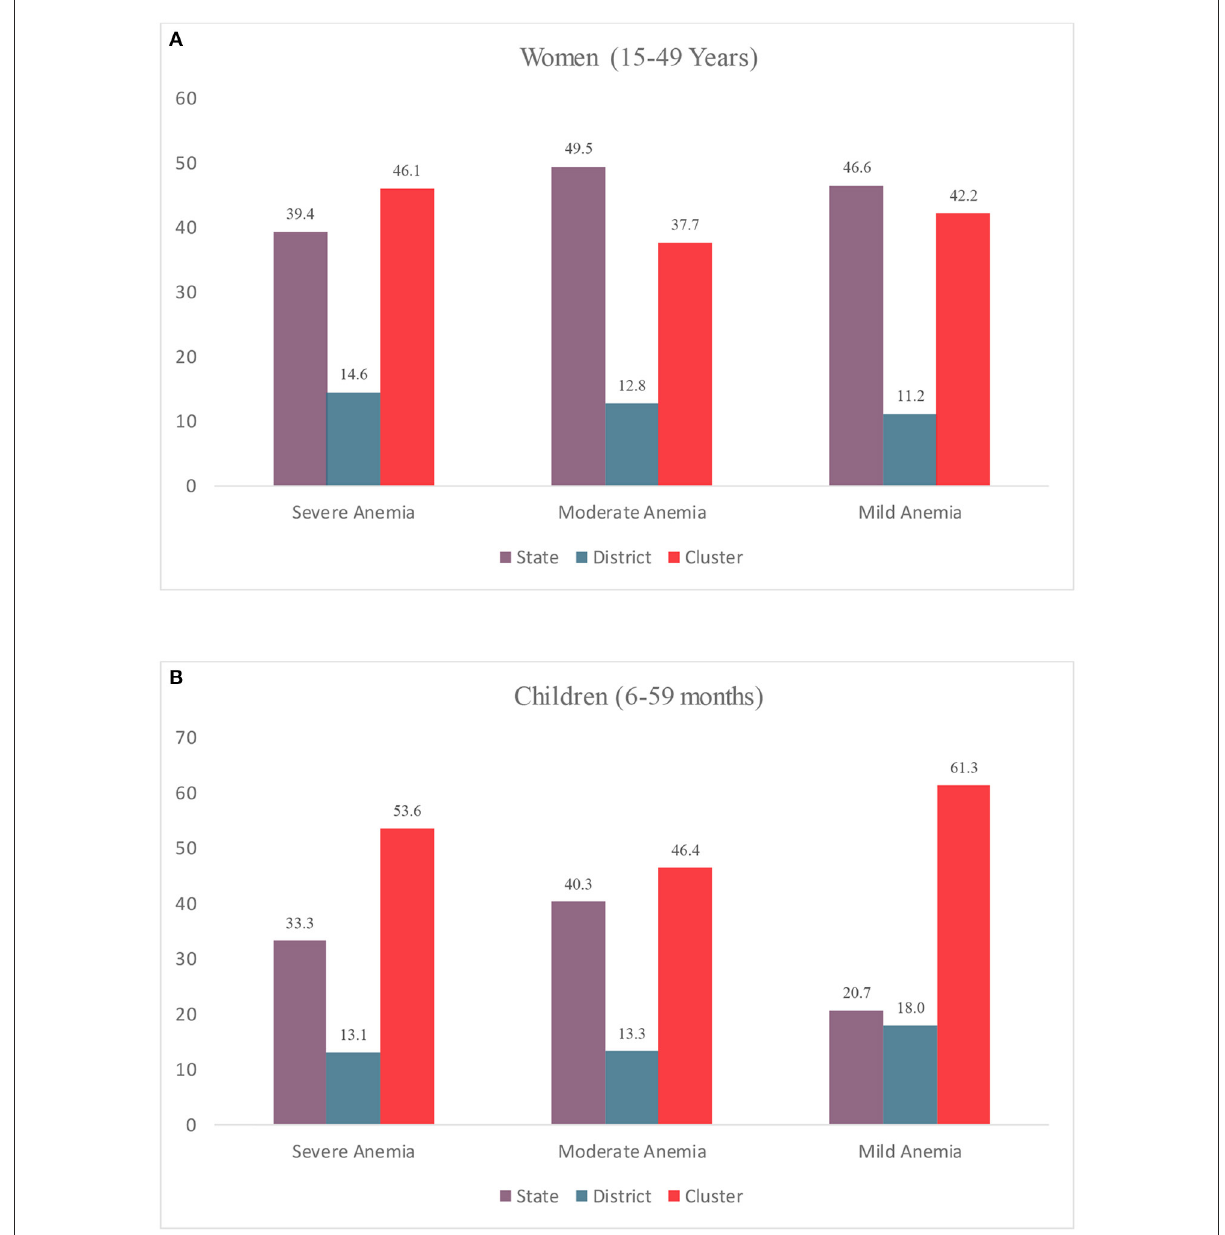
FIGURE2 Variance Partitioning Coefficient (VPC) (%) in anemia among (A) Women (15–49 years); (B) Children (6–59 Months) by multiple geographies, India, NFHS 2021.